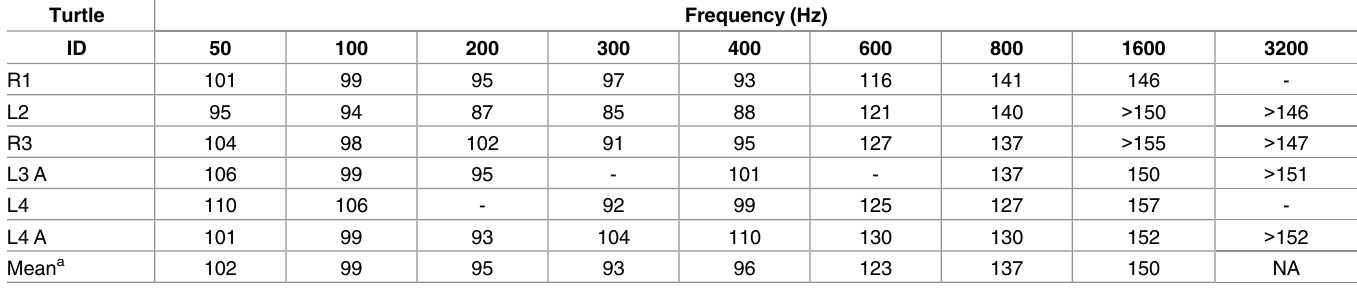
Table 1. Underwater pressure thresholds (dB re: 1 μ Pa-rms)for individual juvenile green sea turtles ( Chelonia mydas ), and mean thresholds for all turtles combined. Frequencies tested with no detected auditory evoked potential response are presented with > “highest sound pressure level pre- sented” (dB re: 1 μ Pa-rms).